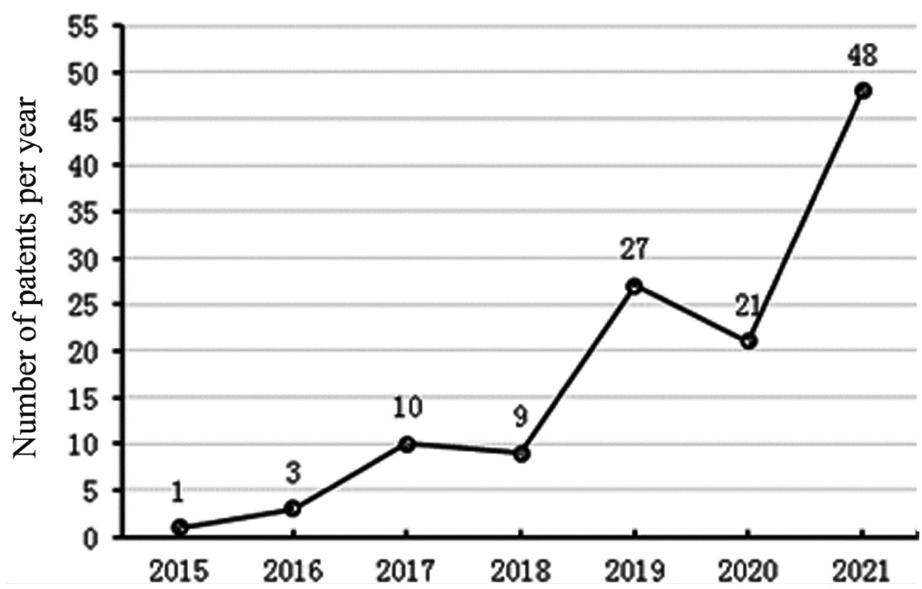
Figure 1. The number of patents per year arising from research on CRISPR-Cas-edited maize from 2015 to 2021.